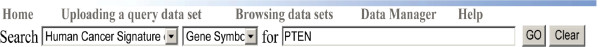
Multiple search entries. From any web page interface of the application, users can access the search tool bar and launch a query. The search tool bar supports seven different search fields including gene name, gene symbol, tissue type, experiment type, signature, samples, and multiple genes. Two drop-down menu lists are used for the selections of a database and a database field. The input text box accepts key words from the user.